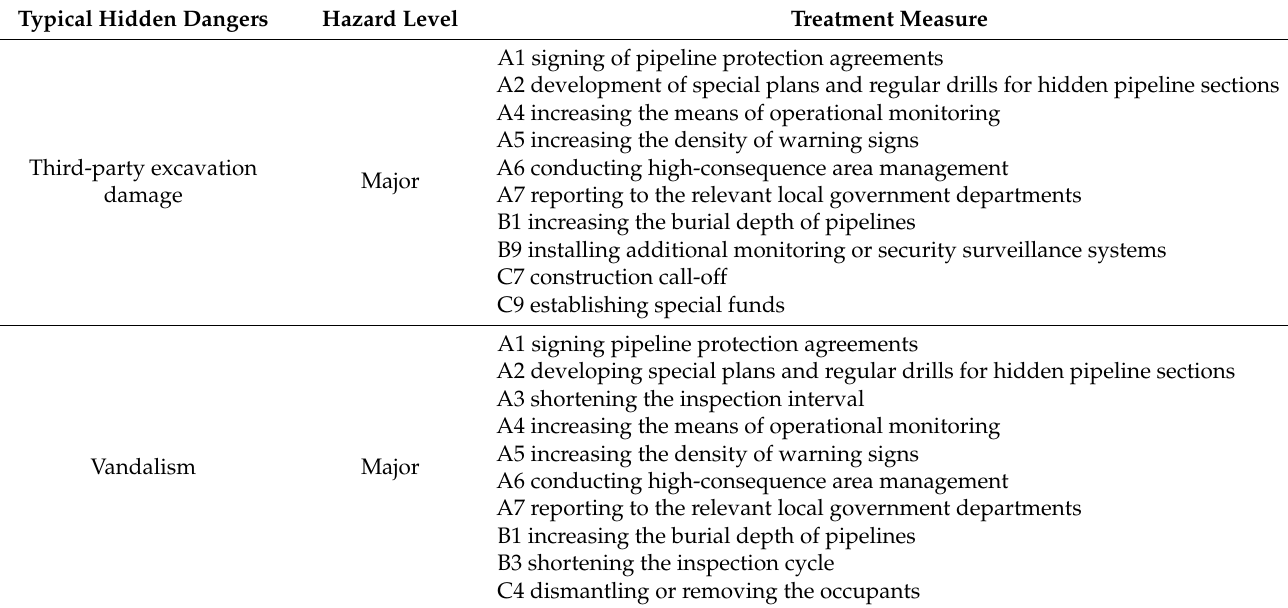
Table 14. Specific measures for graded disposal of hidden